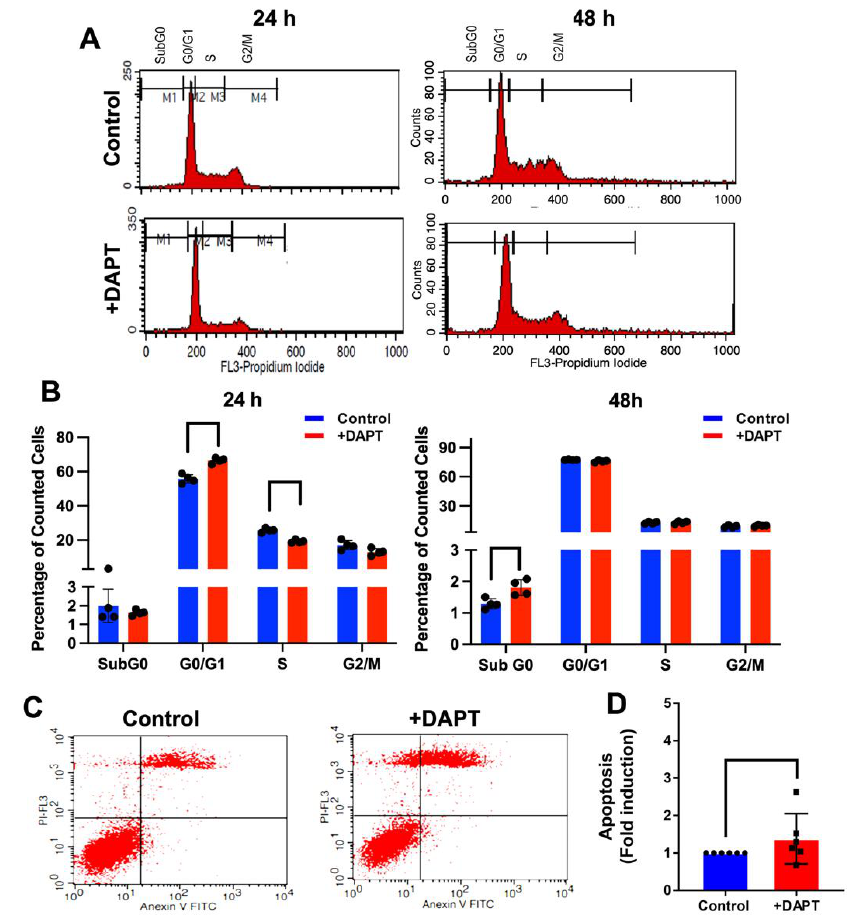
Figure 6. DAPT induced cell cycle arrest and cell apoptosis. Cells were treated with DAPT for 24 or 48 h. DMSO was used as the vehicle control. ( A ) The histogram shows the cell cycle progression analysed by flow cytometry. ( B ) The percentage of the cell population in the cell cycle ( n = 4). For cell apoptosis, cells were stained with Annexin V-FITC and PI after treatment with DAPT for 48 h. The stained cells were analysed using flow cytometry. ( C ) Representative images of apoptosis were evaluated with Annexin V-FITC/PI staining in HSC4 cells. ( D ) The fold change in HSC4 cells ( n = 6). Bars represent a significant difference between groups ( p <